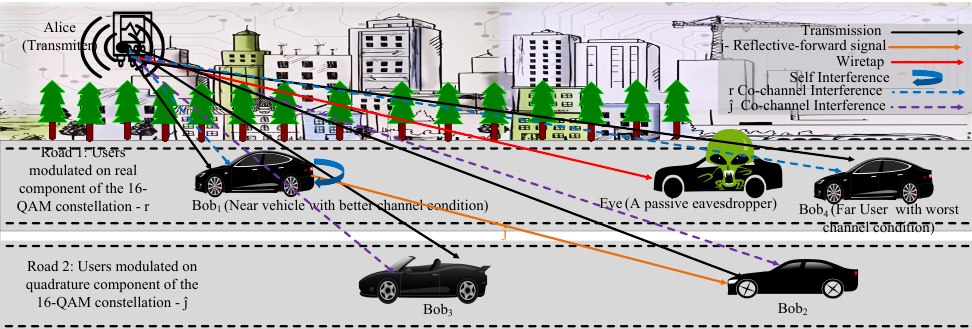
Figure 2. The system model with an Alice, four Bobs and an Eve. Each Bob is modulated dif- ferently following the proposed algorithm, for the reduced NOMA interference. Bob 1 shows the IBFD nature and assists Bob 3 with an R-IBFD transmission. The given system involves self and co-channel